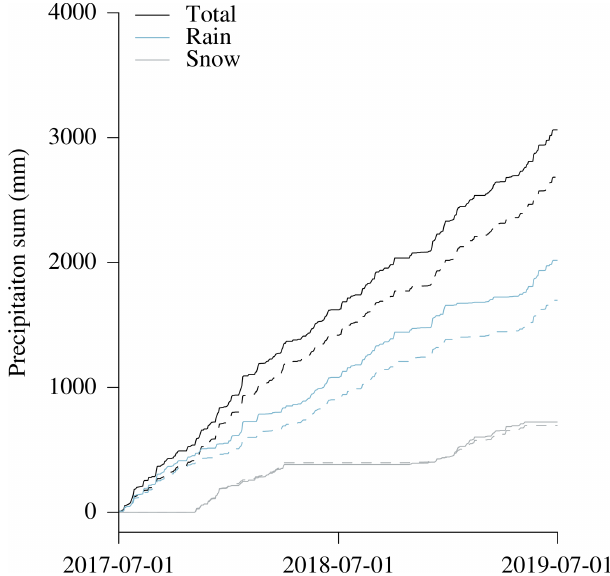
Figure 6. Cumulative precipitation sums as measured by the Thies disdrometer (dashed lines) and the OTT pluviometer (solid lines) during the whole time series (2 years). Precipitation sums are sepa- rated into rain and snow based on the recorded dominant precipita- tion type by the Thies disdrometer